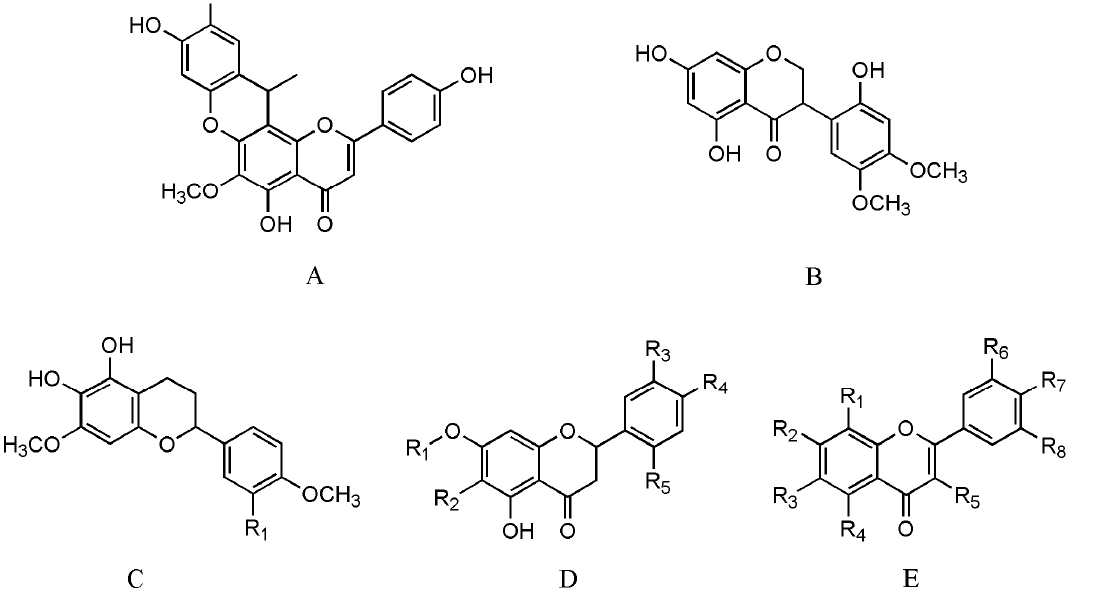
Figure 3. The structures of flavonoids in Salvia species.